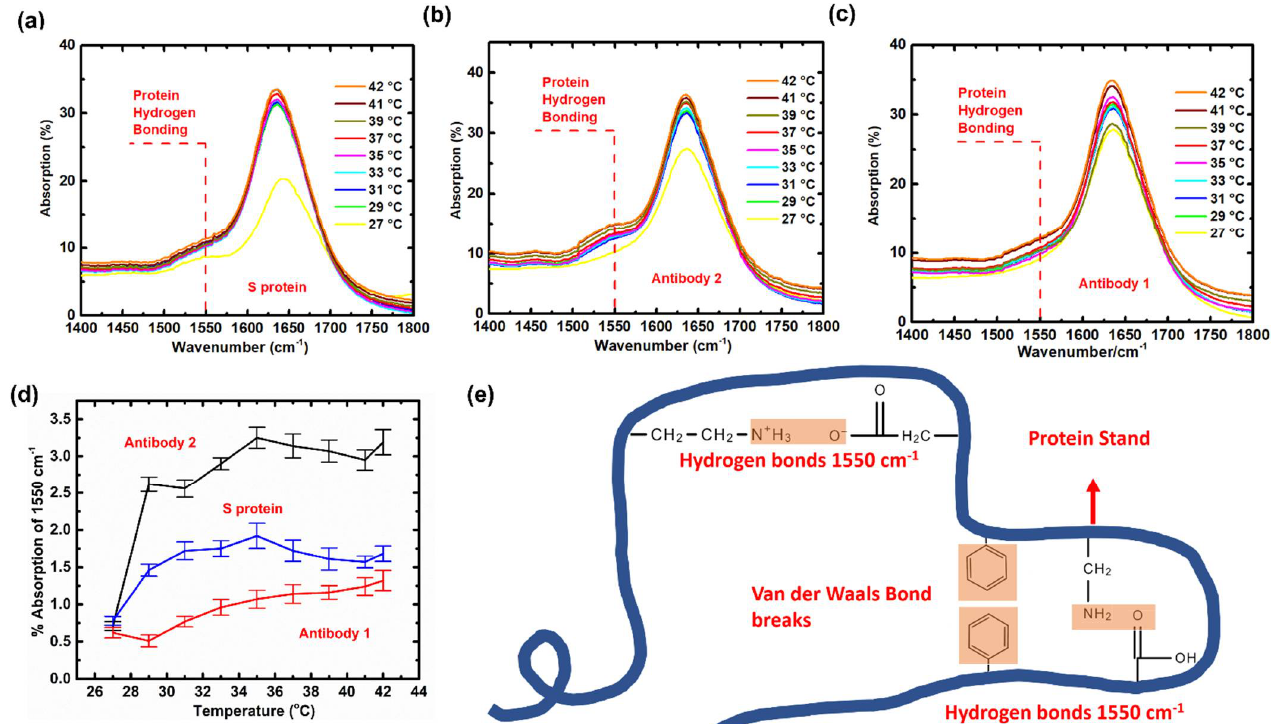
Figure 3. ( a ) The FTIR scan of SARS-CoV-2 spike protein (S protein) in PBS solution for the wavenumber range of 1400–1800 cm − 1 . ( b ) The FTIR scan of SARS-CoV-2 antibody (antibody 2) in PBS solution for the wavenumber range of 1400–1800 cm − 1 . ( c ) The FTIR scan of SARS-CoV-1 antibody (antibody 1) in PBS solution for the wavenumber range of 1400–1800 cm − 1 . ( d ) The infrared absorption of 1550 cm − 1 under variable temperature of SARS-CoV-2 spike protein, SARS-CoV-2 antibody, and SARS-CoV-1 antibody, respectively, given by the difference between the crest near 1550 cm − 1 and the trough near 1480 cm − 1 . The associated error bars were estimated by combining the instrumental error and the possible deviation involved in the computation. All 3 proteins followed a similar trend in temperature, which is attributed to the thermal agitation, when the likelihood increases for such binding sites to pair, either between the neighboring proteins or amongst various strands within a protein or even along a protein strand. ( e ) Schematic illustration of the hydrogen bonding between carboxyl and amino groups within a protein strand, showing the intra-molecular binding of the quaternary structure of proteins when the van der Waals bonds between large pendant groups, such as phenyl, were disrupted, which causes unfolding and exposes more bonding